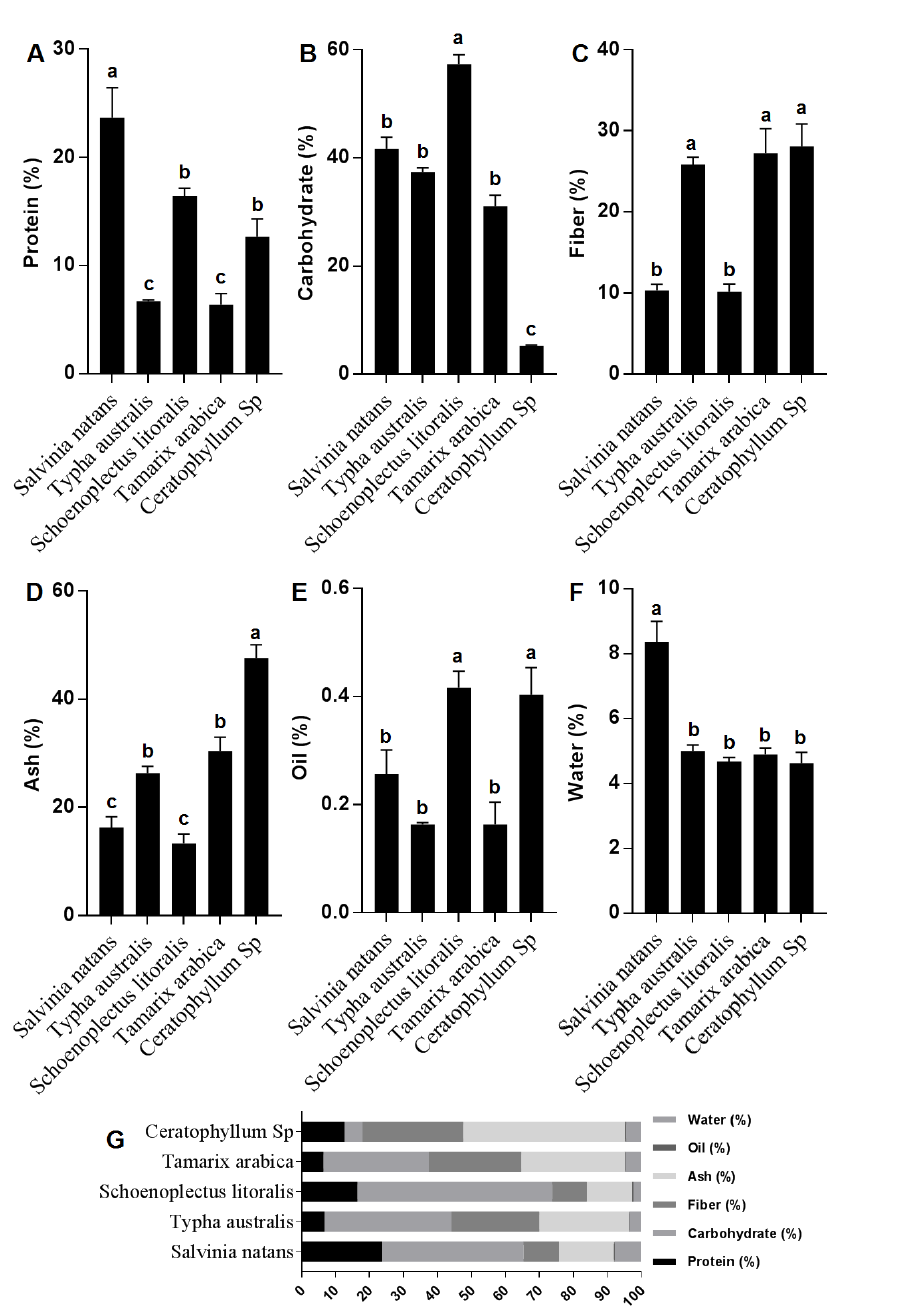
Figure 2: Chemical composition of various plant species inhabit Al-Chibayish marsh based on the air-dried weight. (A-F) represent protein, carbohydrate, fiber, ash, oil, and P< 0.05 water percentages in the analyzed samples respectively introduced as (mean ± SD) compared using Tukey’s test at a probability level of ; (G) represents the accumulated percentages in different plant